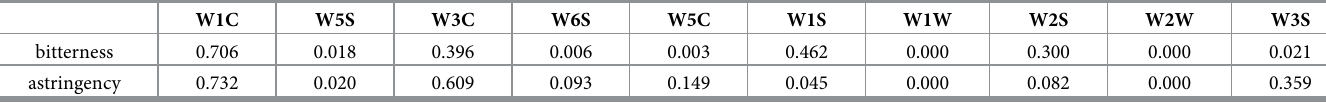
Table 3. Significance analysis between electronic nose and